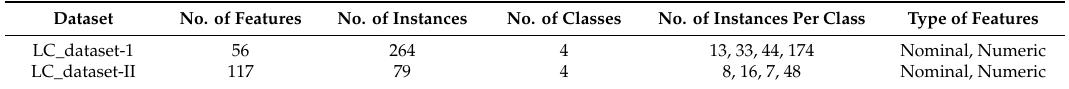
Table 2. Characteristics of two datasets used in the